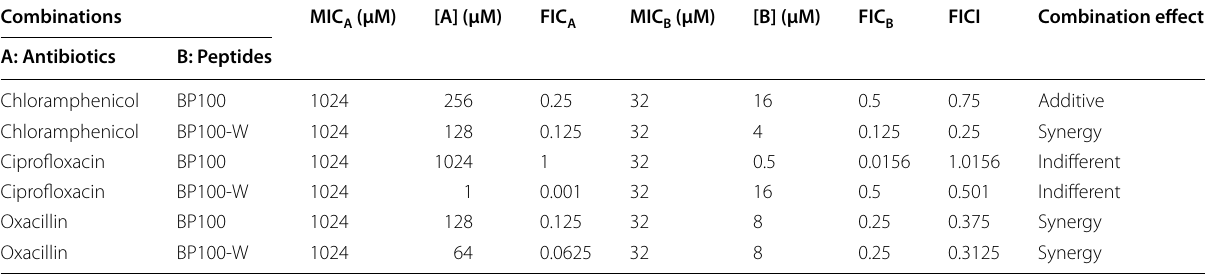
Table 4 FICI a of the peptides in combination with conventional antibiotics against methicillin-resistant Staphylococcus aureus (MRSA) (CCARM 3089)